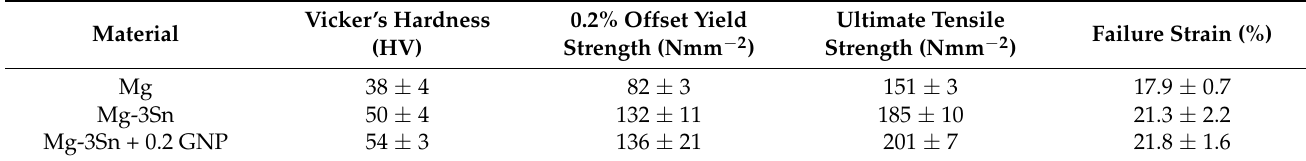
Table 2. Micro-hardness and tensile properties at room temperature (24 °C).